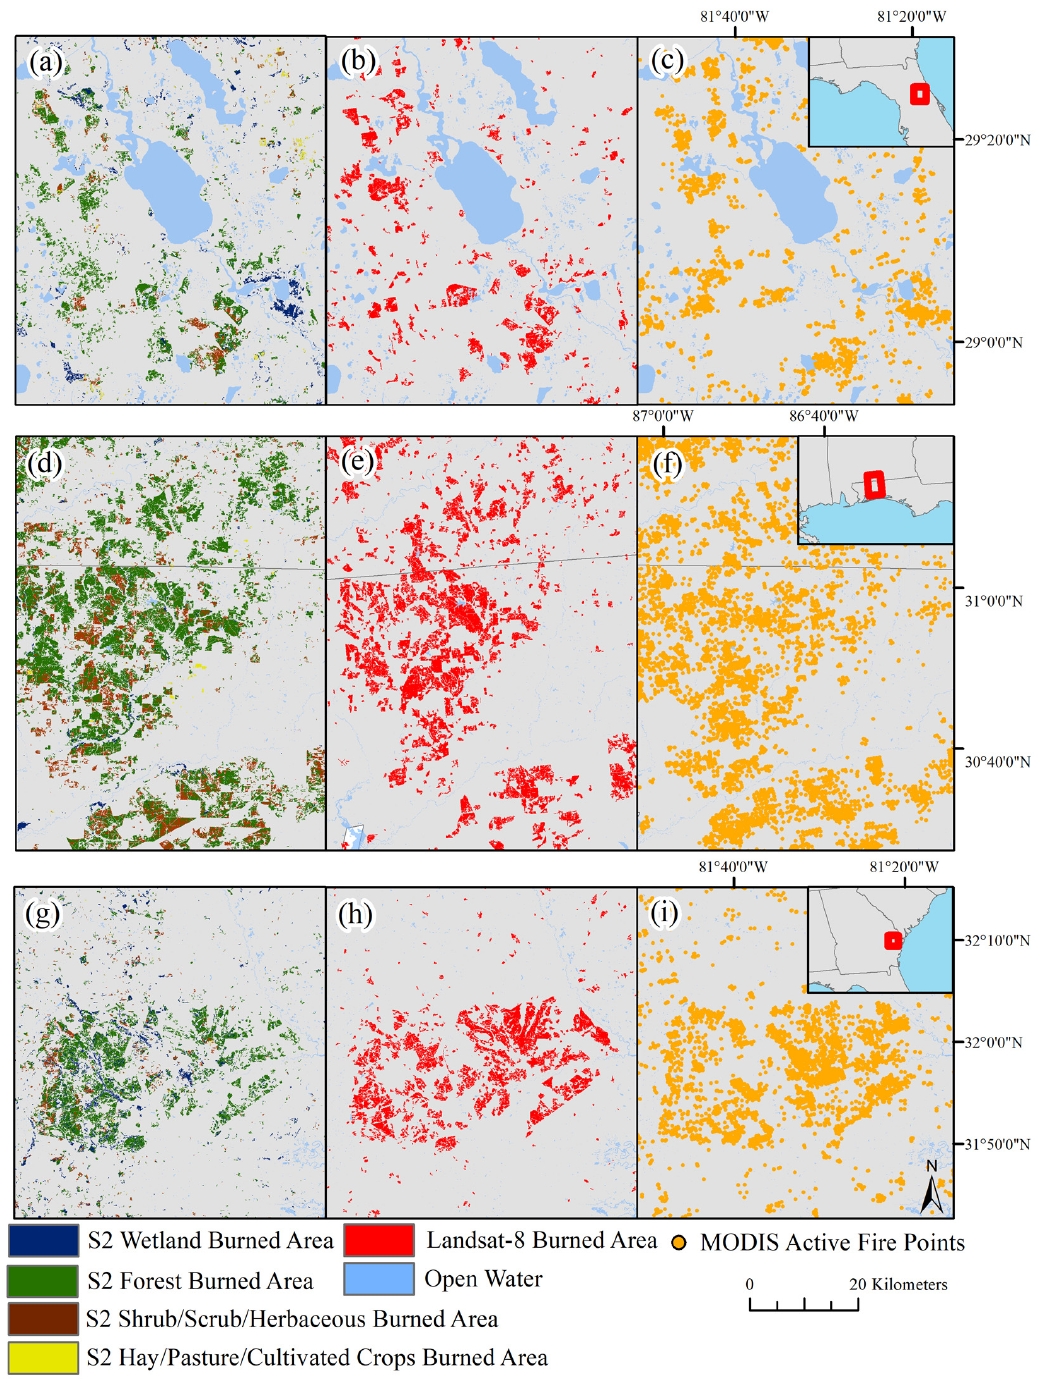
Figure 9. Examples of applying the Sentinel-2 (S2) burned area algorithm ( a , d , g ) to areas beyond the training point extent and in areas where the burned area occurred predominantly in non-wetland vegetation types (2016–2019) compared to the Landsat-8 Burned Area Product ( b , e , h ), and the Moderate Resolution Imaging Spectroradiometer (MODIS) active fire points ( c , f , i ). Land-cover types assigned to the Sentinel-2 burned area were derived from the 2016 National Land Cover Database [55].